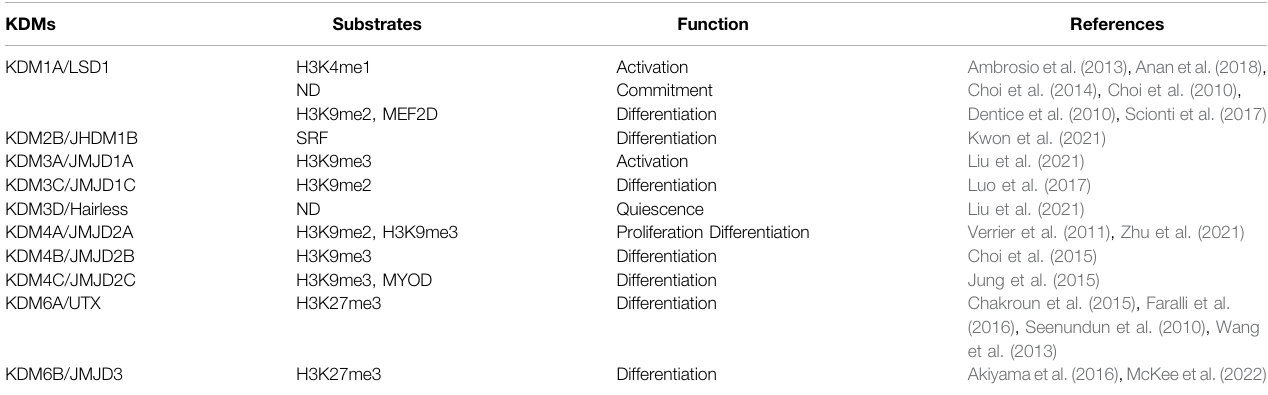
TABLE 1 | List of histone demethylases that regulate MuSC fate choice. KDMs